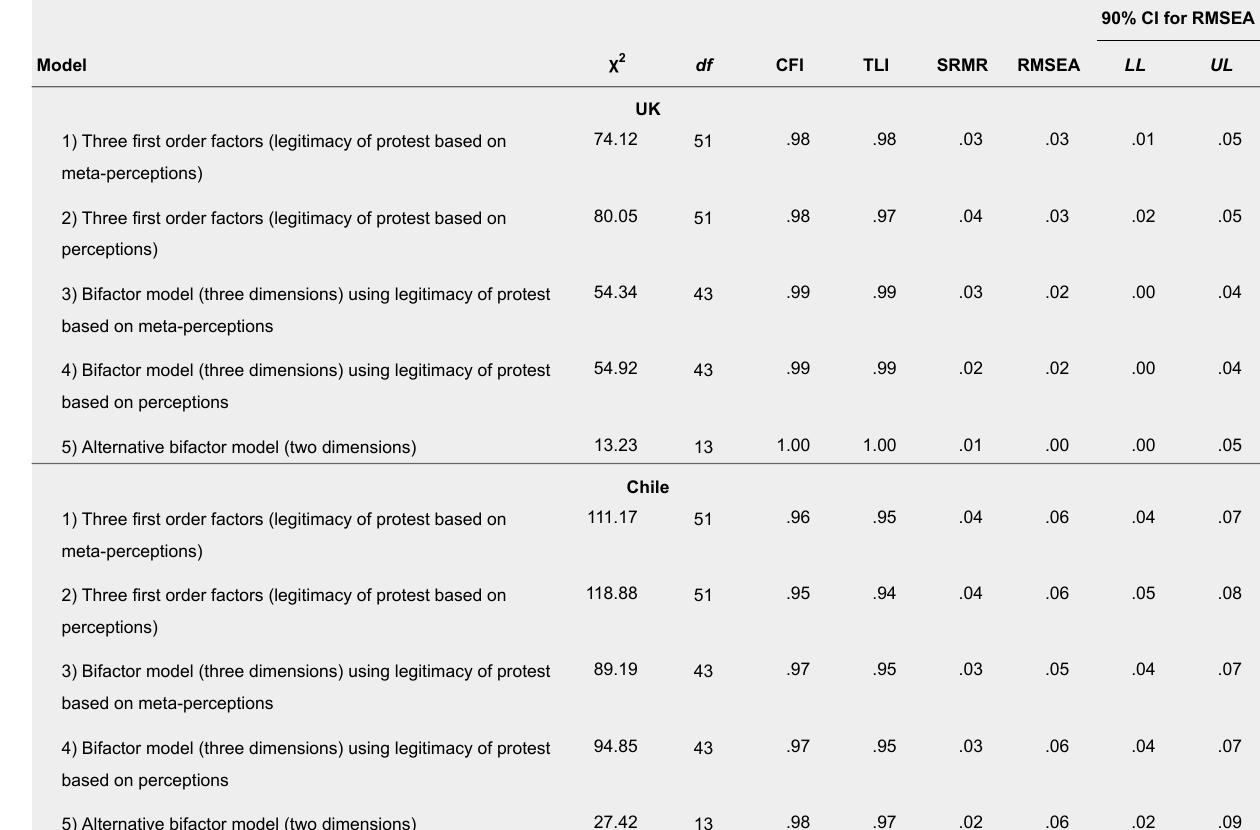
Model Fit Statistics and Close-Fit Indices Associated with CFA Models by